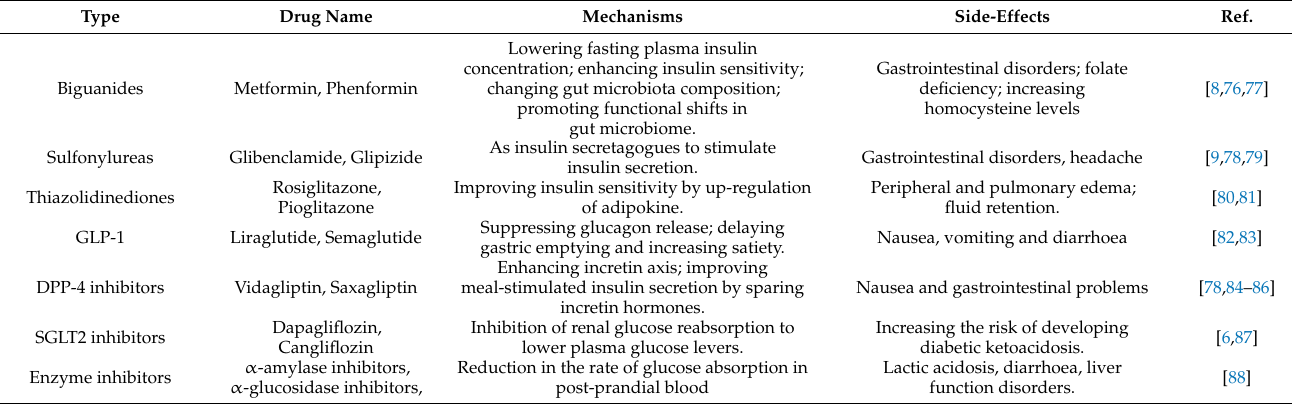
Table 2. Drugs used in amelioration of